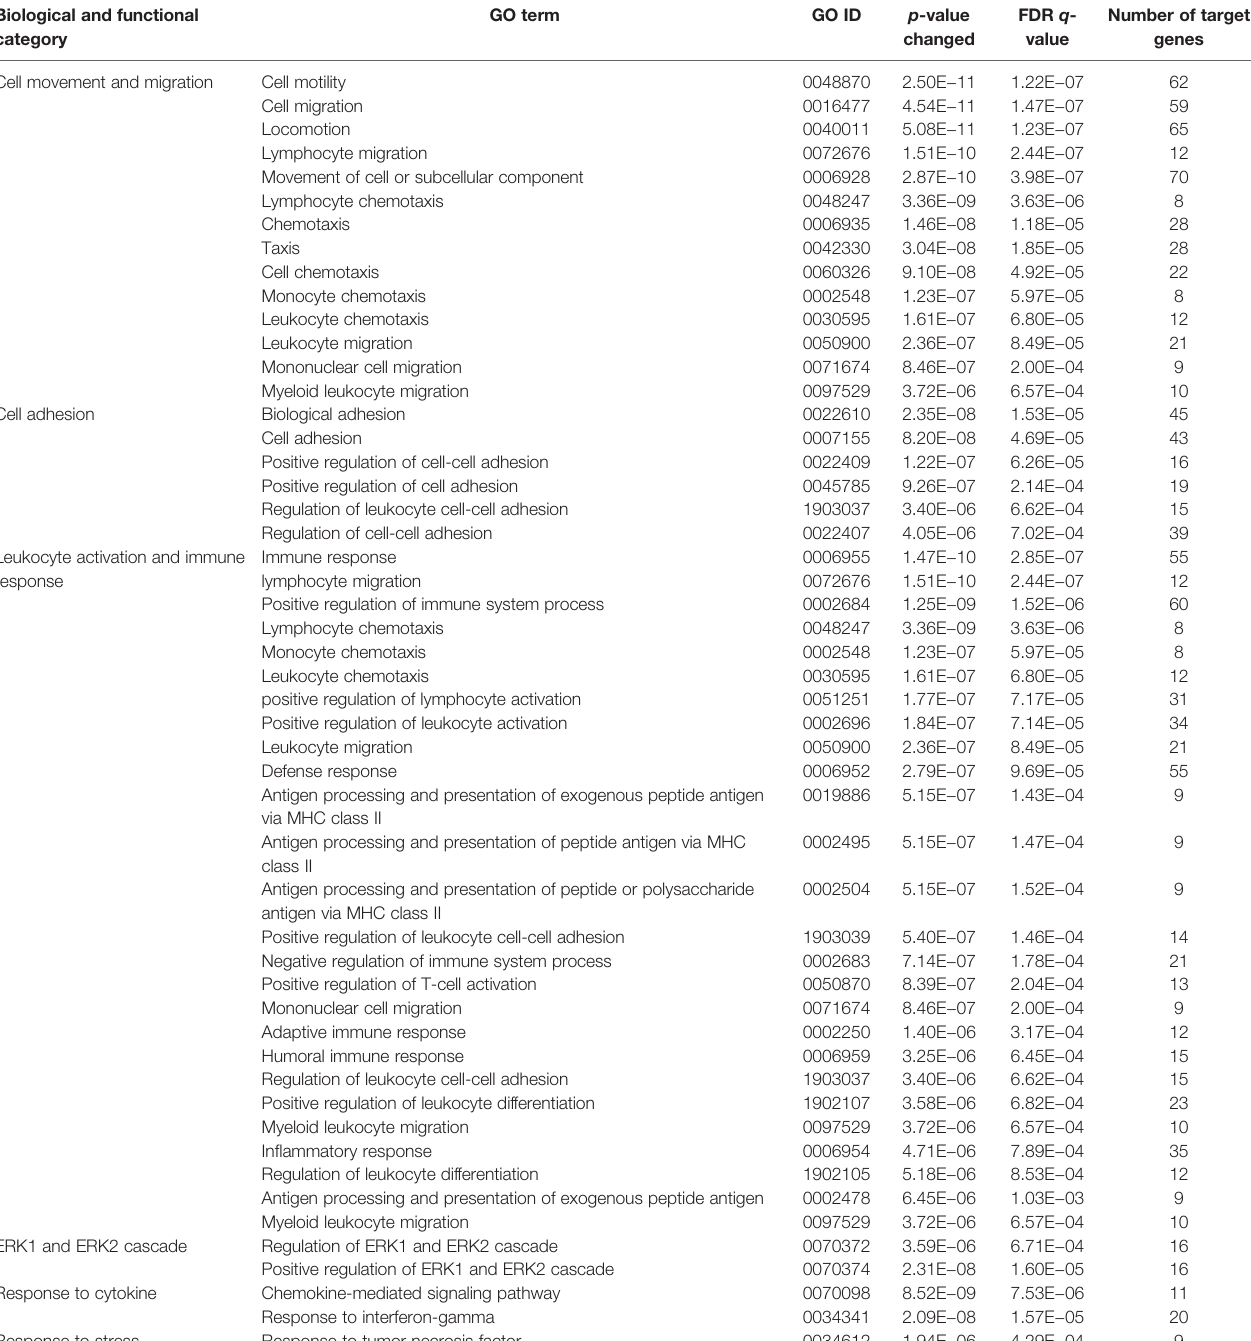
GO term GO ID p -value